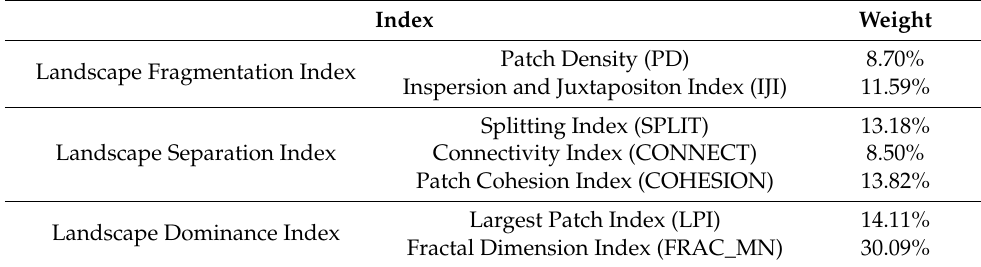
Table 4. Index Weight.